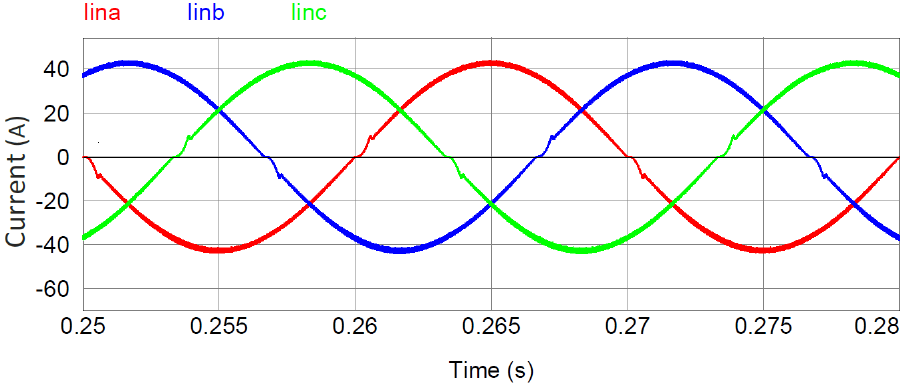
Figure 11. Rectifier input currents (full power, Table 1).